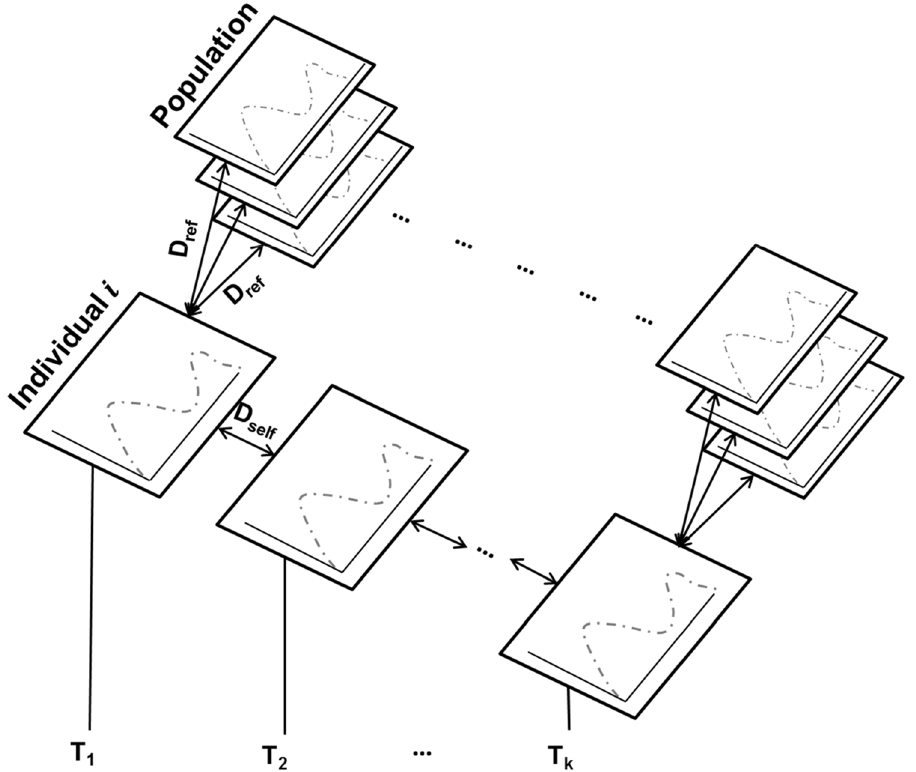
Figure 1. Illustrative view of the persistence analysis process applied to the circadian rhythms of activity. Here, D self corresponds to the dissimilarity measured between the daily rhythms of two successive periods of time (which vary from T 1 to T k ) of an individual i , named intra-individual dissimilarity. D ref correspond to the dissimilarities measured between the daily rhythms of an individual i and the other individuals of the observed population within a same time period, named inter-individual dissimilarities. Persistence is validated if and only if D self that is measured between two successive time windows tends to minimize D ref ’s that are measured for each of these two time windows